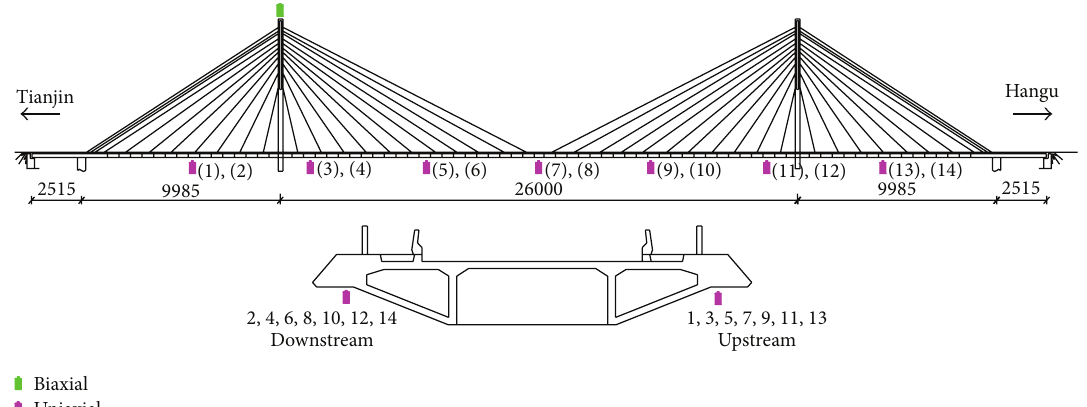
Figure 1: Yonghe bridge elevation and accelerations health monitoring system.